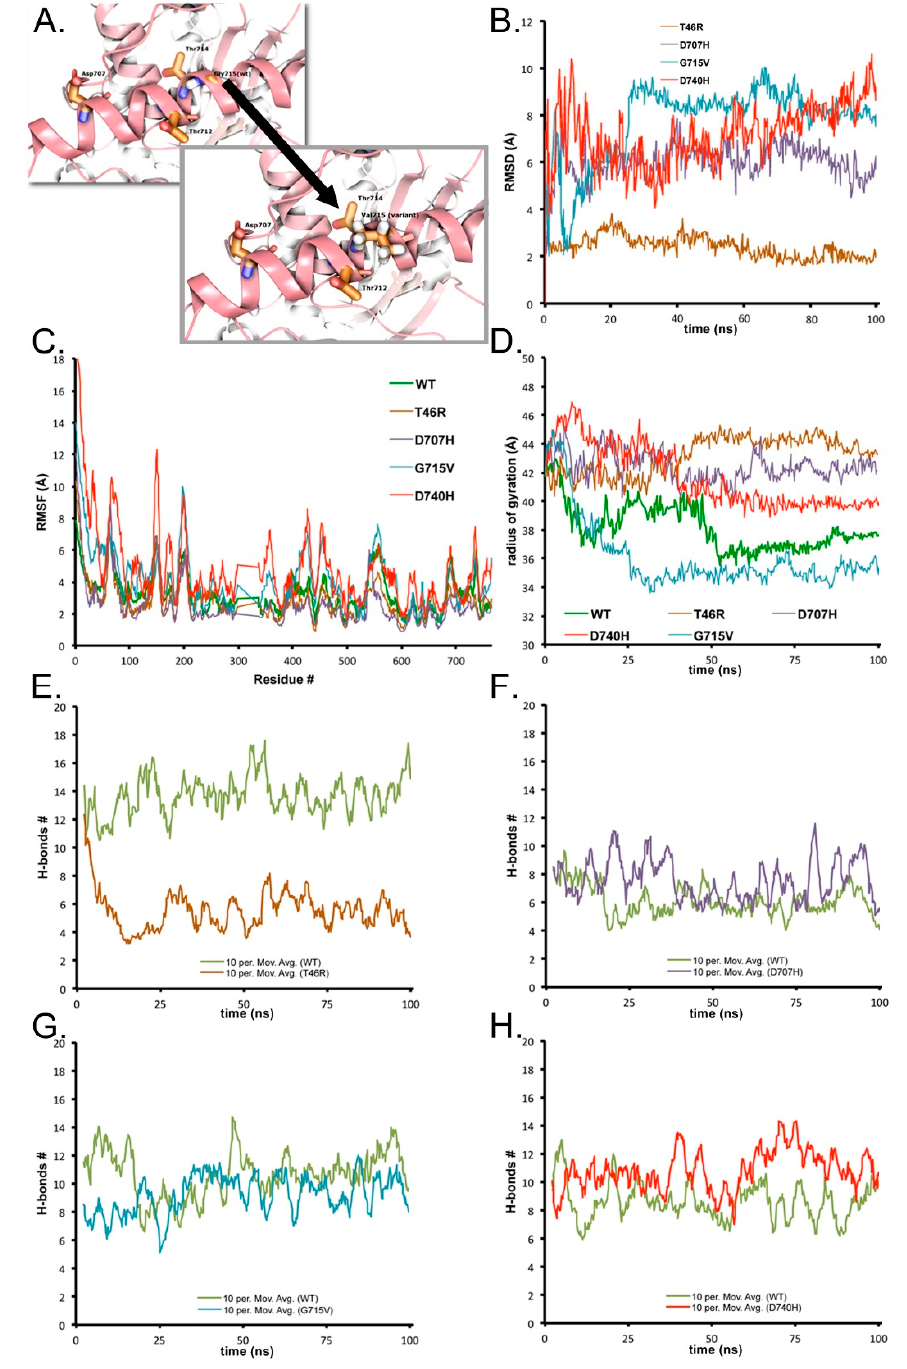
Figure 3. Analytical metrics for decomposition of SIM1 variants versus WT behavior. ( A ) Key example for a pathogenic variant, G715V (panel 1 and 2 showing before and after variant). Colored by domain and rendered in ribbons and licorice sticks for adjacent amino acids. ( B ) Local root-mean-square-deviation for each variant is given, where the local region is defined as all residues within 8 Å of the selected variant. ( C ) Per residue root-mean-square-fluctuation over entire simulation timeframe (>500 ns combined). ( D ) Radius of gyration measurement for each protein as a measure of the particles’ size over time. ( E ) T46R: Amount of hydrogen bonding present within an 8 Å cutoff of T46R versus the same amount of H-bonds present in WT during simulation. ( F ) D707H: Amount of hydrogen bonding present within an 8 Å cutoff of D707H versus the same amount of H-bonds present in WT during simulation. ( G ) G715V: Amount of hydrogen bonding present within an 8 Å cutoff of G715V versus the same amount of H-bonds present in WT during simulation. ( H )